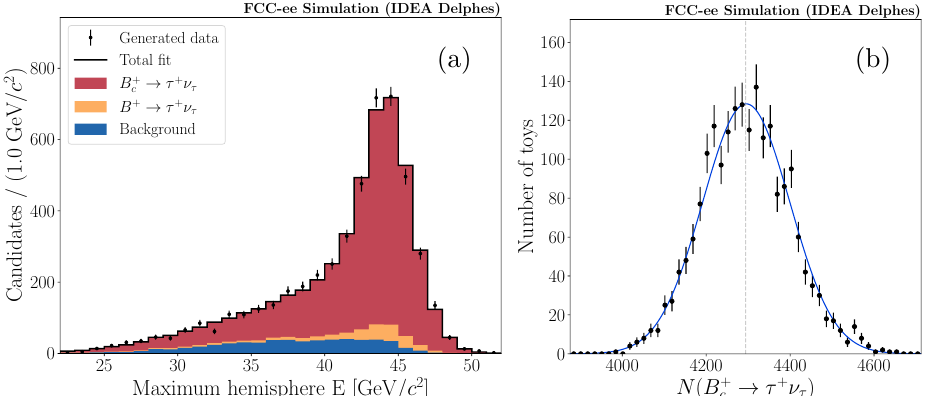
Figure 6 . (a) Result of a single pseudoexperiment fit, where the peaking signal is clearly distin- guishable from the background. (b) Signal yields measured in 2000 pseudoexperiment fits, where the generated value is indicated by the dashed vertical